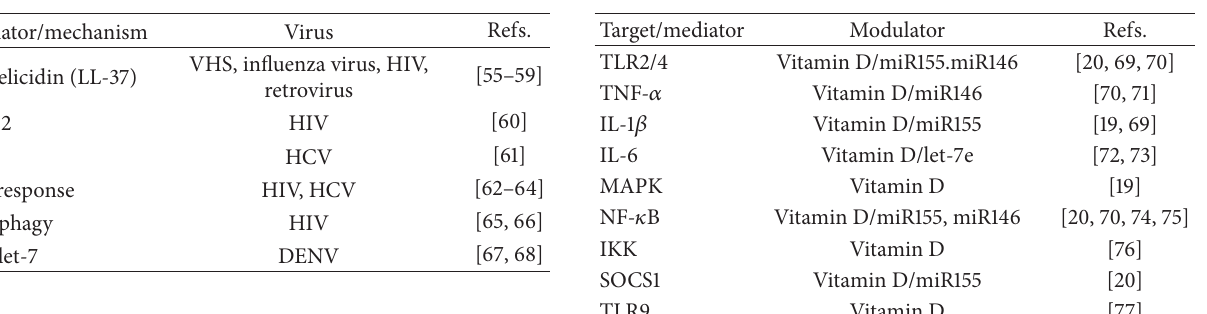
Table 2: Vitamin D-induced mechanisms/mediators associated with antiviral activity.